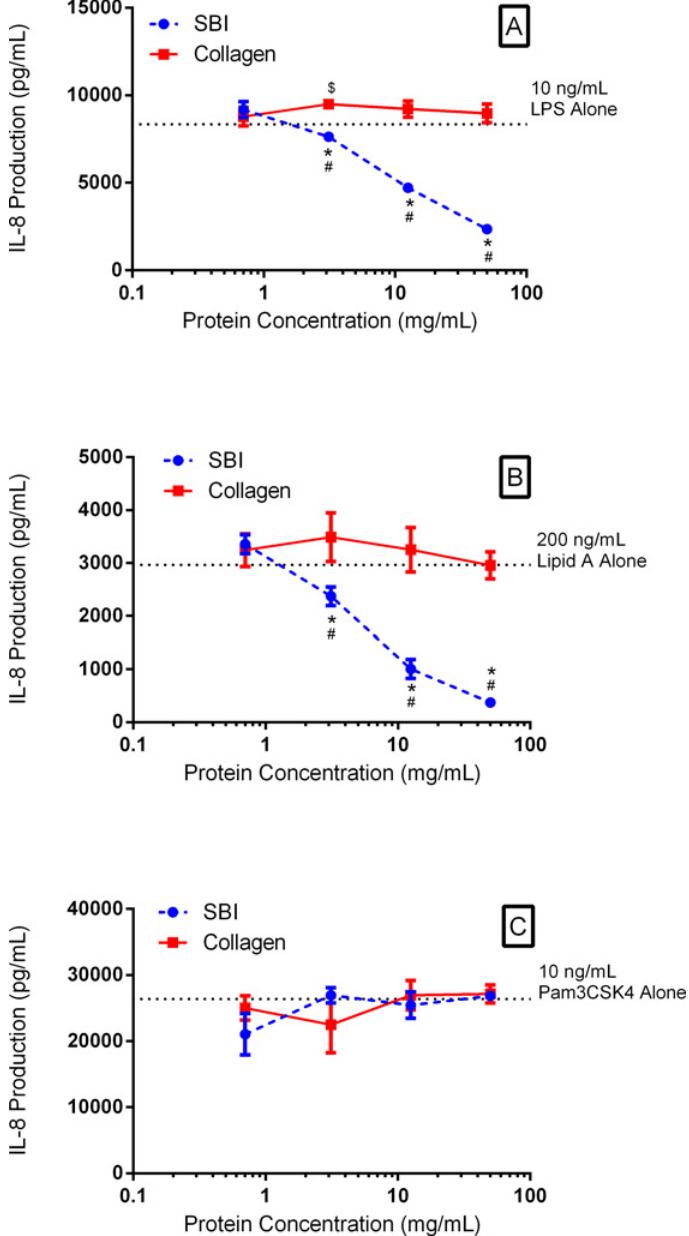
Fig 3. Immune Exclusion of Test Antigens. Immune exclusion of LPS (A) and Lipid A (B) induced IL-8 pro- inflammatory cytokine production was observed by the addition of SBI. Cytokine production by LPS and Lipid A was increasingly inhibited as the SBI concentration was increased from 1 mg/mL to 50 mg/mL. Immune exclusion of Pam3CSK4 (C) was not observed as the addition of SBI did not affect cytokine production. The control protein collagen did not affect cytokine production induced by any test antigen. * indicates P < 0.05, when comparing the difference between SBI and collagen. # indicates P < 0.05, when comparing the immune exclusion of SBI at varying concentrations to the amount of IL-8 produced when the antigen is added alone. $ indicates P < 0.05, when comparing the immune exclusion of collagen at varying concentrations to the amount of IL-8 produced when the antigen is added